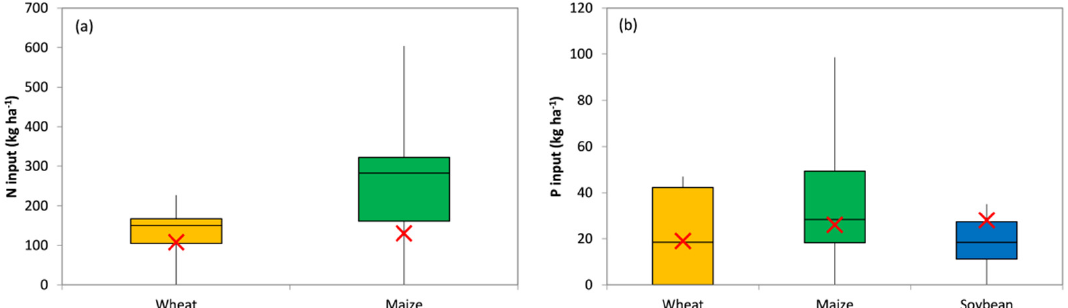
Figure 3. Nitrogen ( a ) and phosphorus ( b ) supplies under real-field conditions for the studied crops irrespective of agronomic management. N = 28, 35, and 28 for wheat, maize, and soybean, respectively. The balancing points (i.e., output-to-input ratio equal to 1) are estimated from the LTE interpolations and identified using red x symbols.